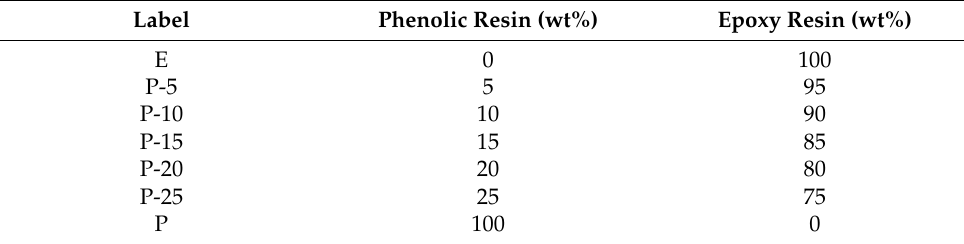
Table 4. Formulation and label of each